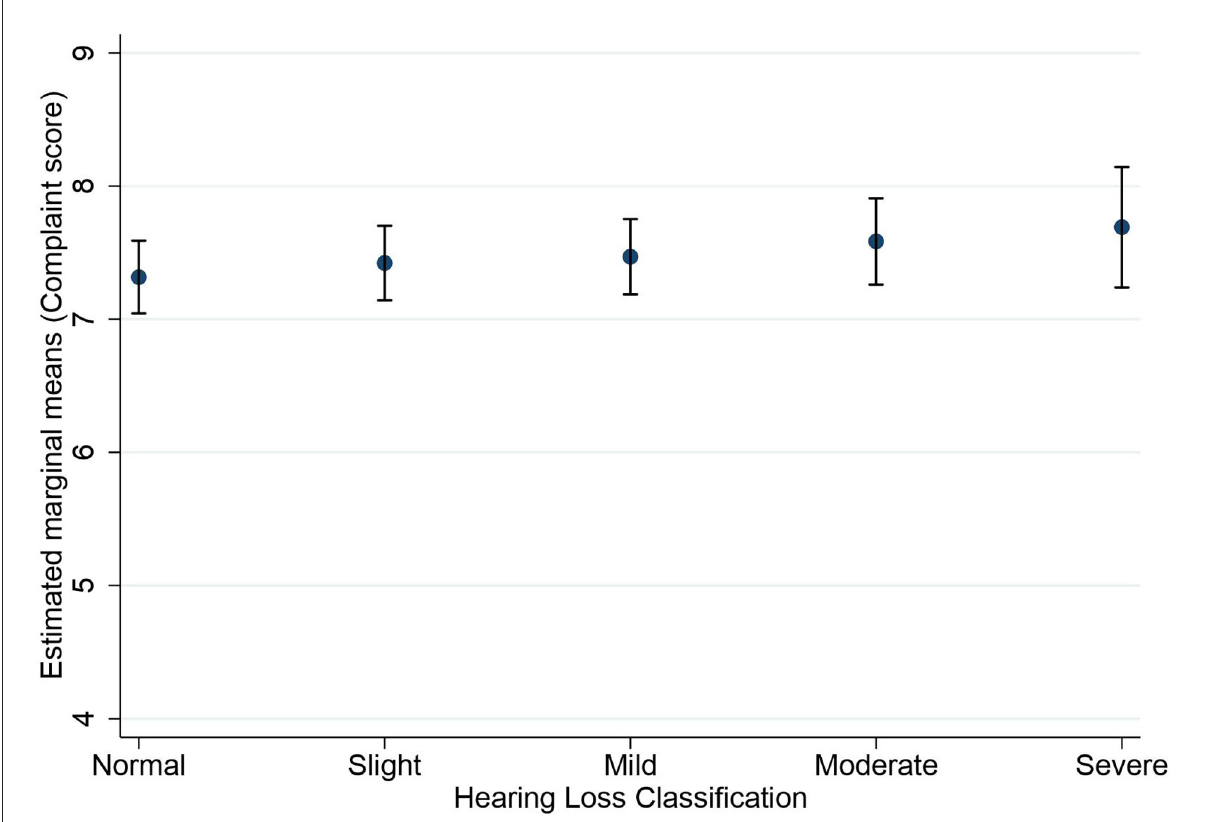
FIGURE1 Estimated marginal means of subjective long-term memory complaints as a function of hearing status. Estimates are averaged over the levels of age at the means of the covariates sex, education, stroke, diabetes, smoking, and hospital admission for a head injury. The error bars indicate 95% confidence